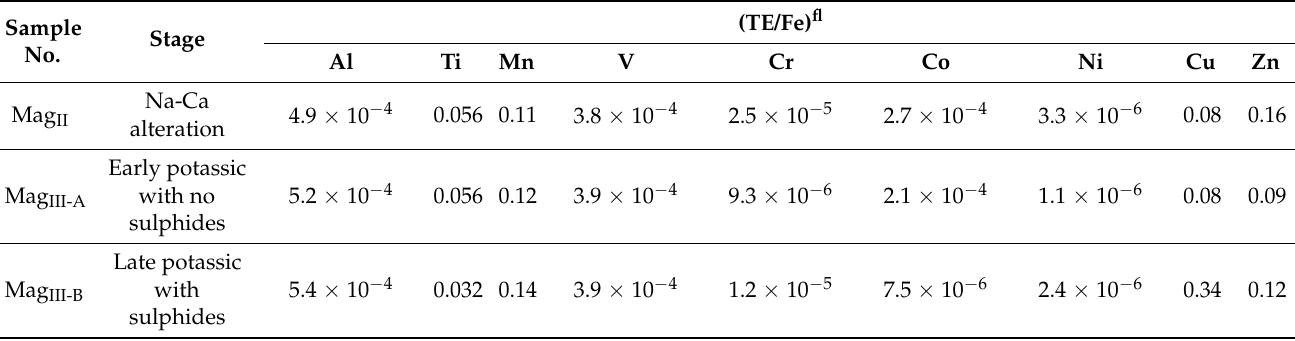
Table 4. Proportions (TE/Fe) fl calculated on the basis of obtained D Mt / fl hydrothermal stages (450–400 ◦ C) of the formation of the Yuleken porphyry Cu-Mo deposit (NW China) [15]